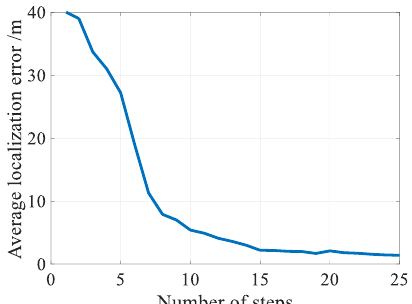
Figure 22. Matching accuracy vs. trajectory length.